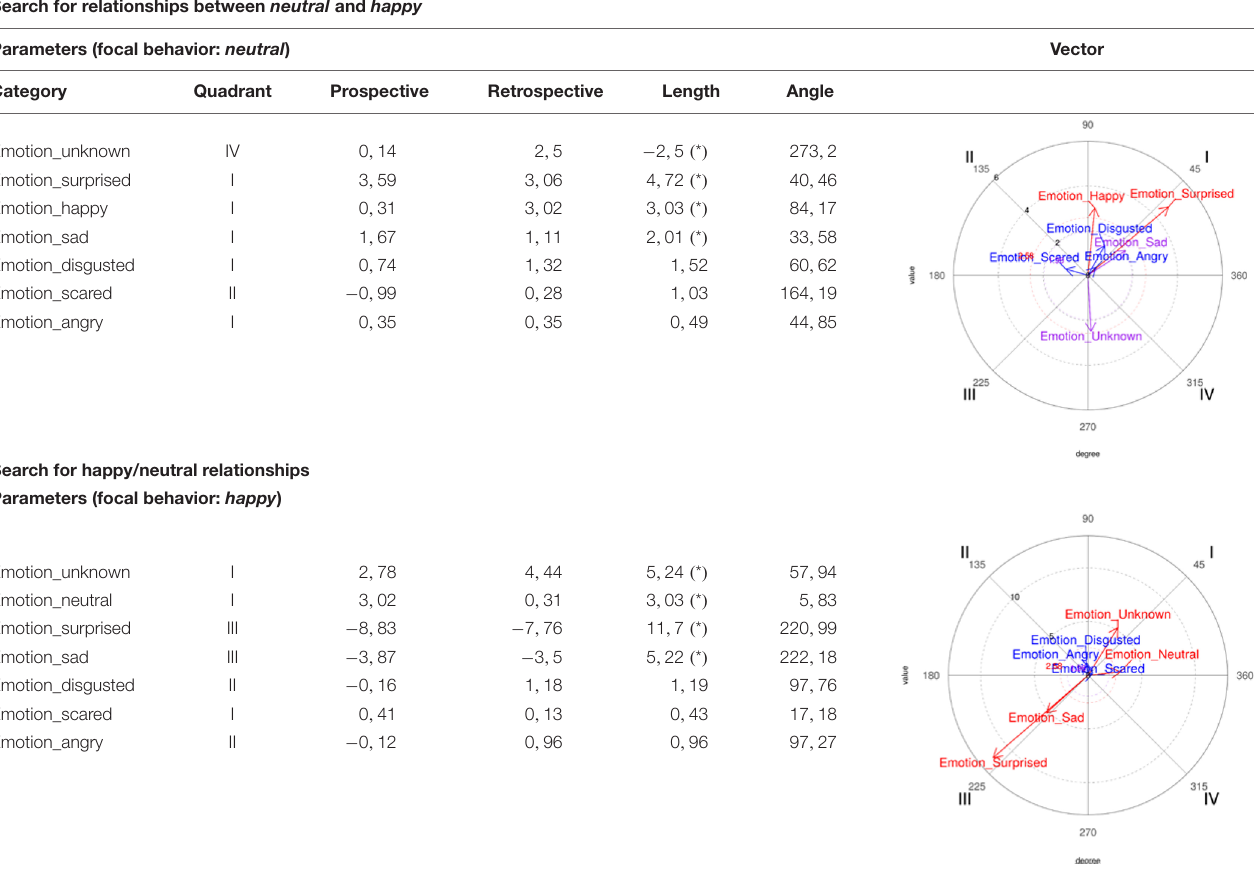
TABLE 5 | Polar coordinate analysis centered on neutral / happy and on happy / neutral , corresponding to the boys’ records. Search for relationships between neutral and happy Parameters (focal behavior: neutral )